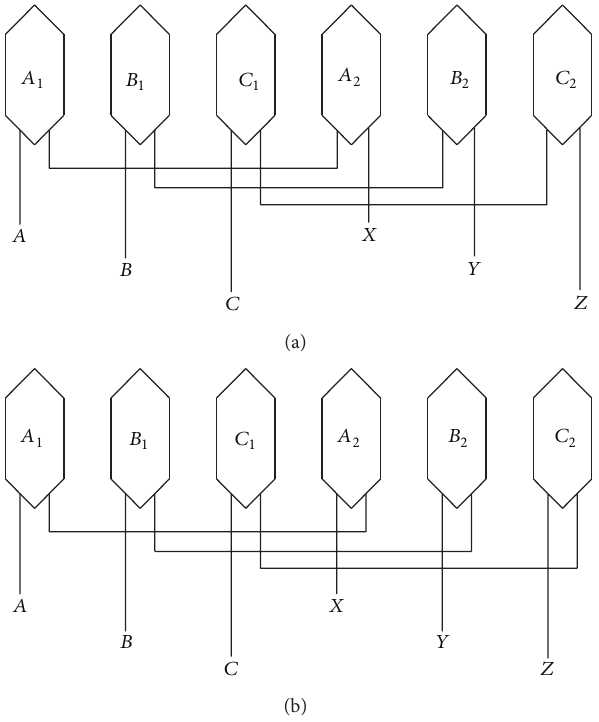
Figure 2: Schematics of armature windings. (a) Existing LVH machine. (b) Proposed LFTPMV